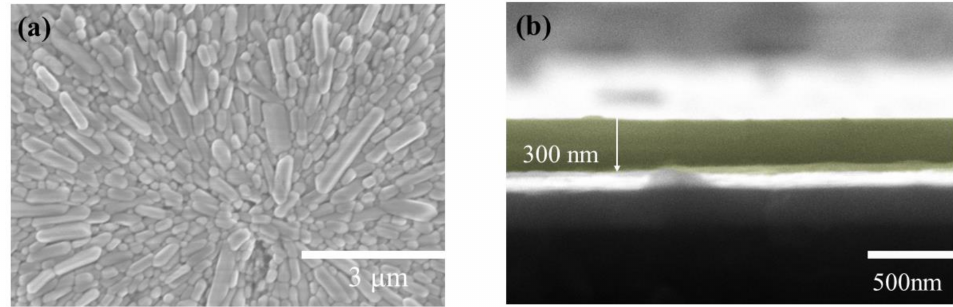
Figure 2. ( a ) The surficial SEM images of the Au/CsPbI 3 /ITO artificial synapse; ( b )the cross-sectional SEM images of the Au/CsPbI 3 /ITO artificial synapse. The yellow part is CsPbI 3 .